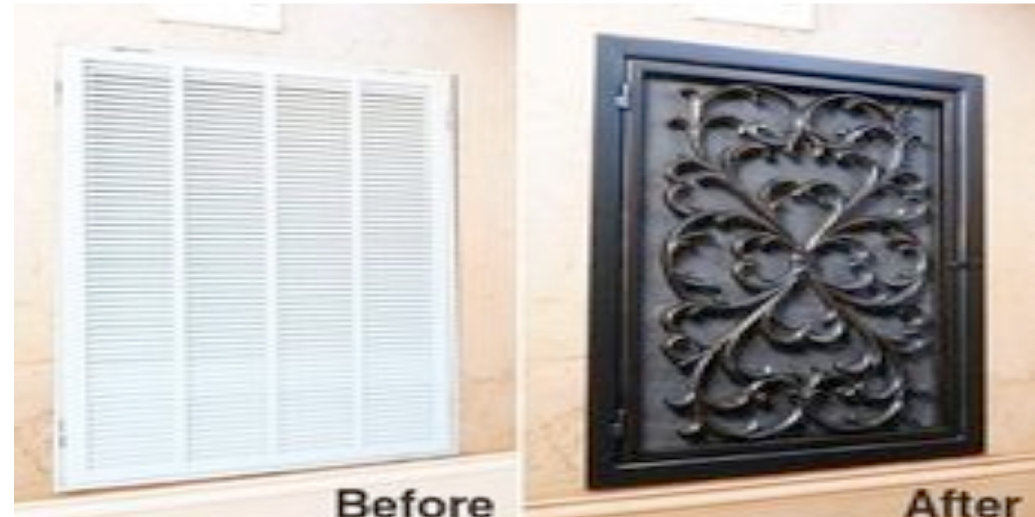
Fig. 4. Ventilation grille with new design.